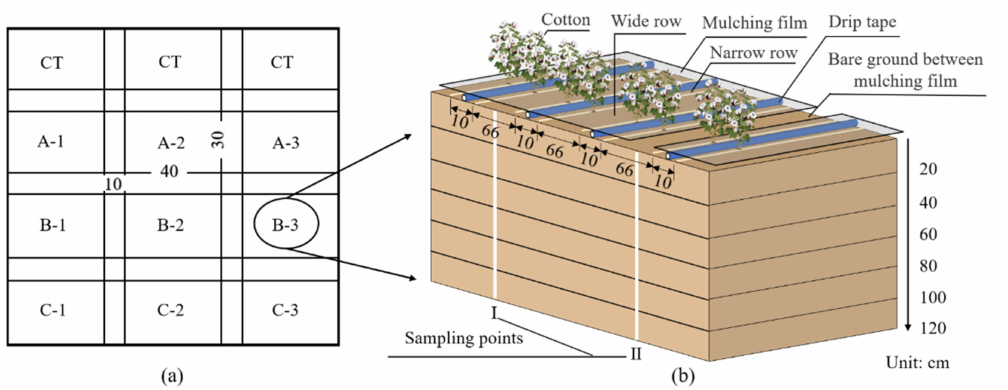
Figure 2. ( a ) The layout of the experimental plots and ( b ) a vertical section of the experimental plots. CT, conventional tillage; A, 20 cm; B, 40 cm; C, 60 cm.